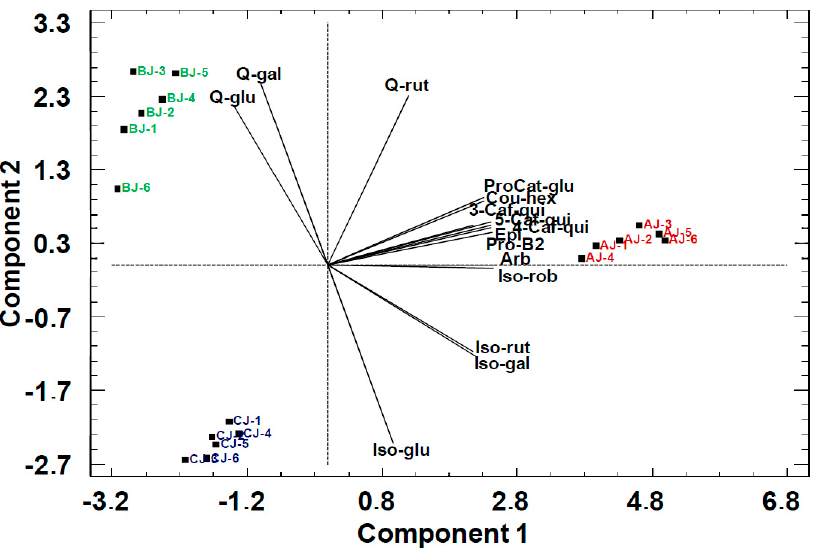
Figure 4. PCA bi-plot of pear juices with phenolic compounds as statistical variables. AJ: Alejandrina juice, CJ: Conference juice, and BJ: Blanquilla juice. PC1: 71%, PC2: 25%.